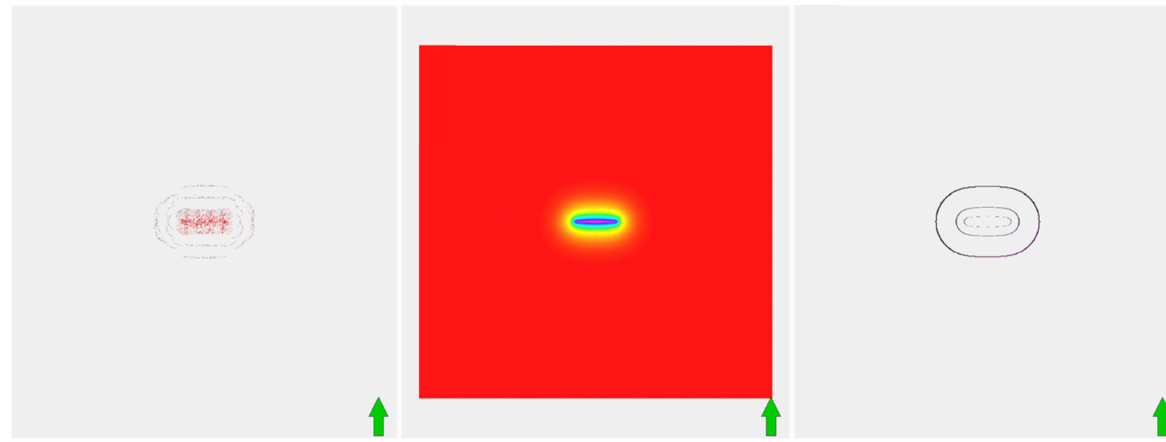
Figure 10. Transition from Linear to Pseudo-Radial.